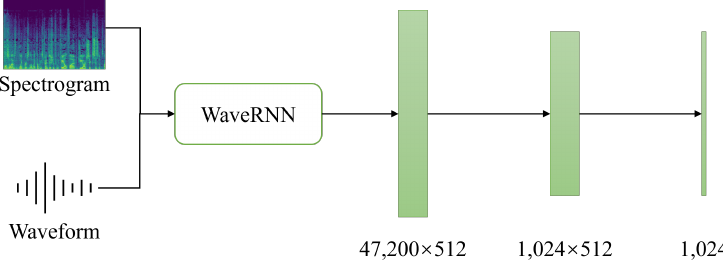
Figure 3. The classifier added to